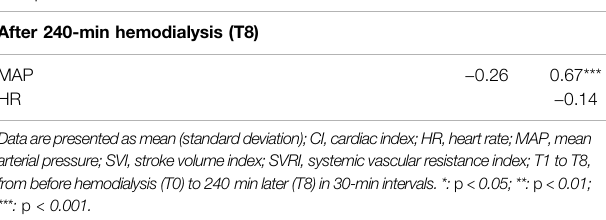
TABLE 6 | Pearson ’ s correlation coef fi cients between parameters for time points. TABLE 6 | ( Continued ) Pearson ’ s correlation coef fi cients between parameters for time